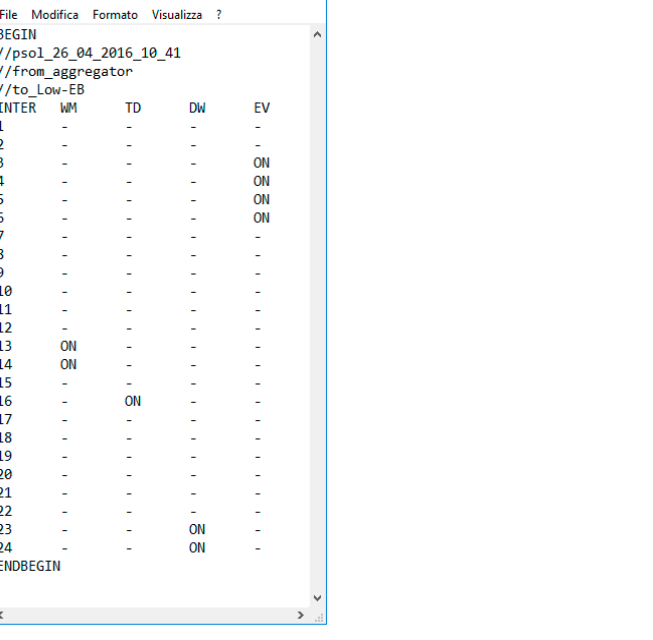
Figure 14. The optimal load scheduling according to the prosumer problem solution.